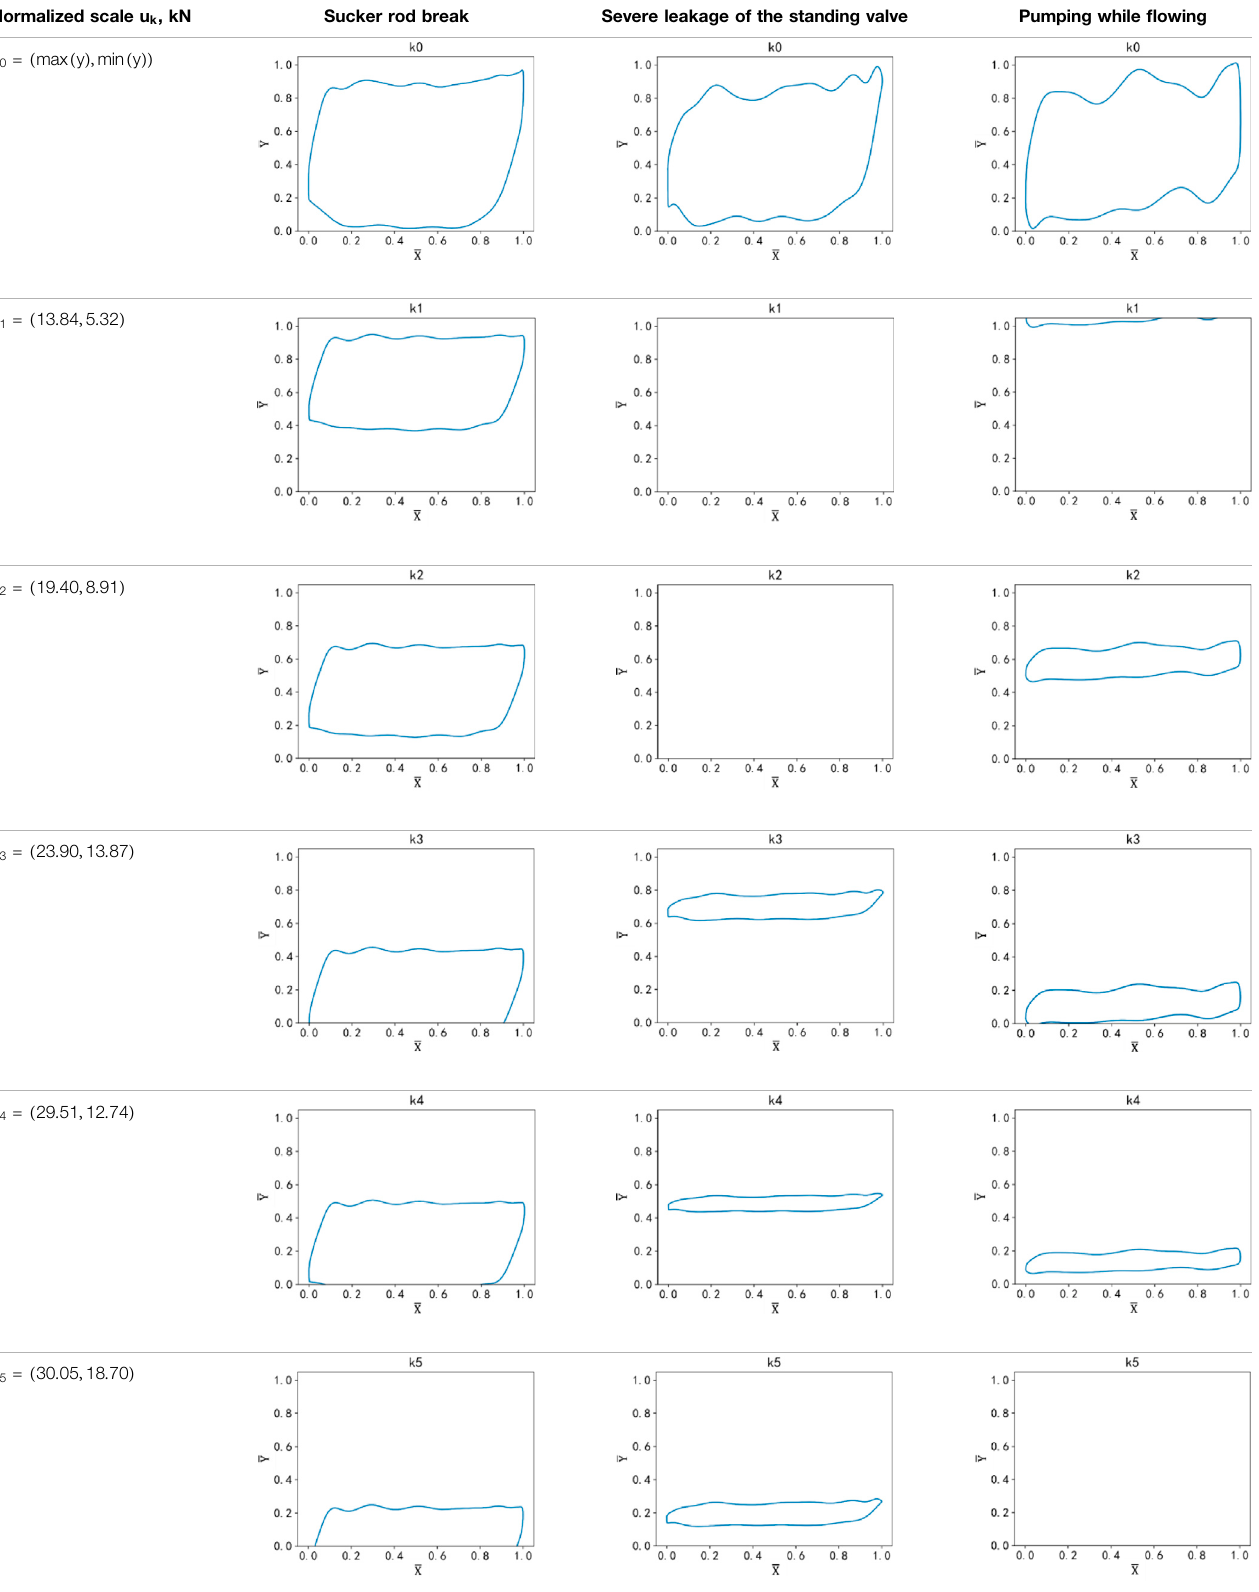
TABLE 3 | Normalized dynamometer card of three working conditions (k = 10). Normalized scale u k ,